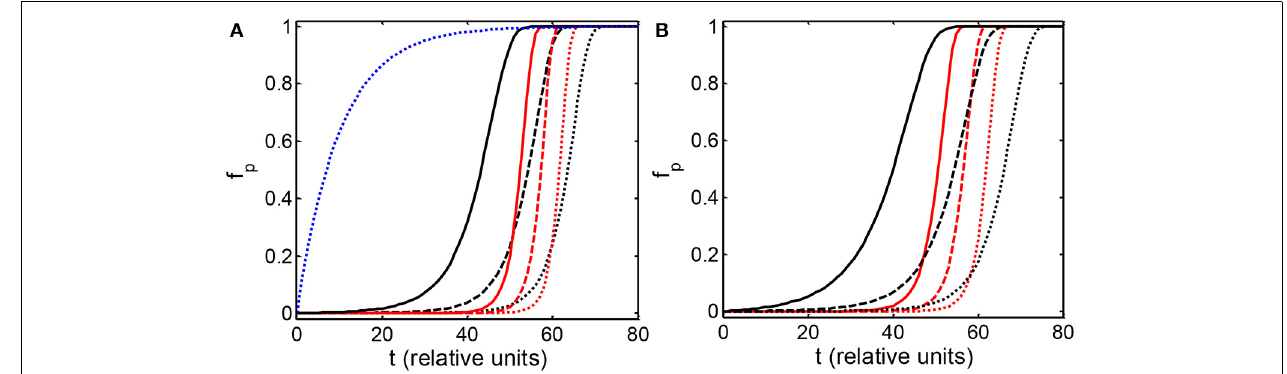
FIGURE 1 | Dependence of the mass fraction of polymer upon elapsed time, calculated according to the condensation model (A) and the fibrillation model (B) as described in the text. Parameters associated with